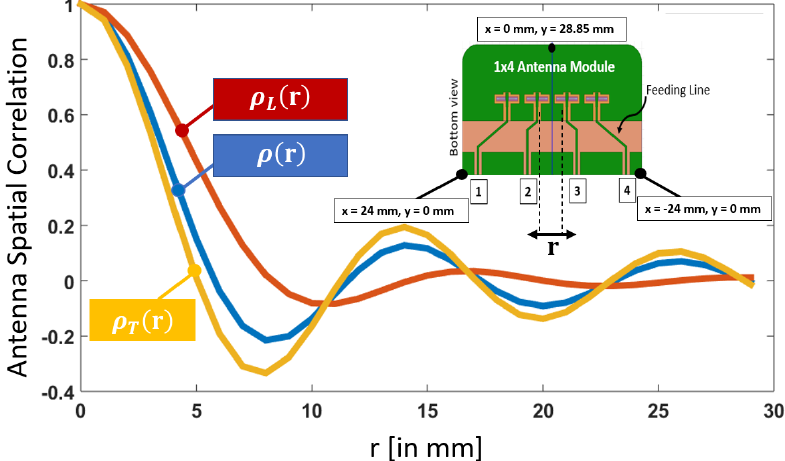
Figure 4. Transverse, longitudinal and total antenna spatial correlation as a function of the separa- tion distance r between array elements.